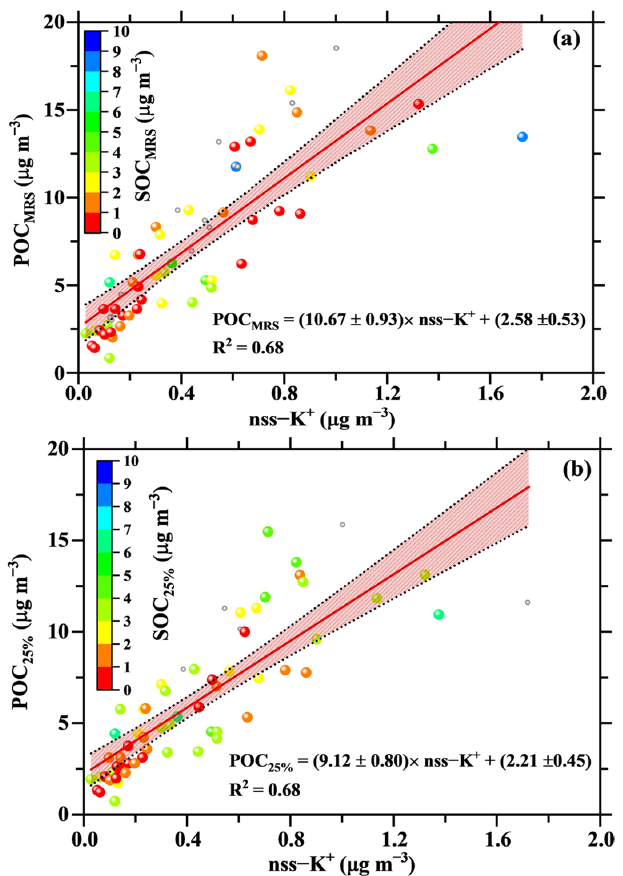
Figure 4. Correlations between nss-K + and POC estimates via the MRS ( a ) and 25th percentile ( b ) methods in Nainital as a function of the respective SOC estimates. The red line shows the linear regression and the red shaded area the limits of the linear regression at 95% confidence level.